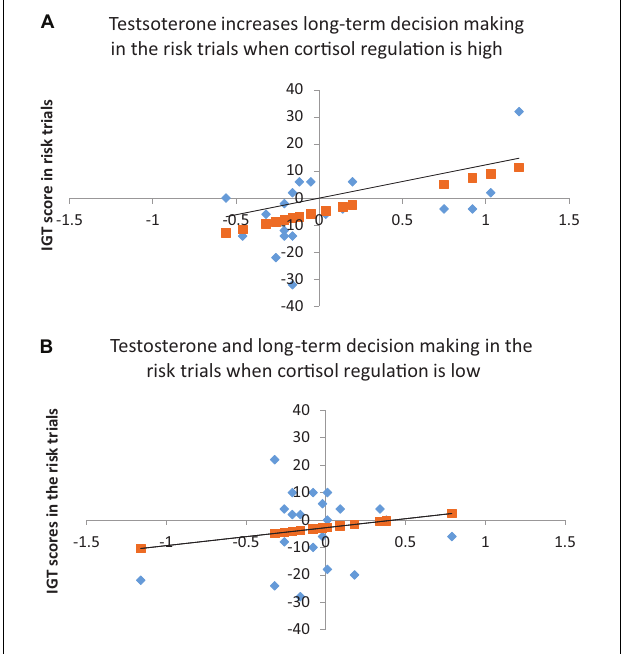
FIGURE 1 | (A) Testosterone and long-term decision-making in the risk trials when cortisol regulation is high ( R 2 = 0.29, p < 0.05). (B) Testosterone and long-term decision-making in the risk trials for low cortisol regulation ( R 2 = 0.03, p > 0.05). Linear regression line shows the predicted long-term choices in the risk trial ( Y